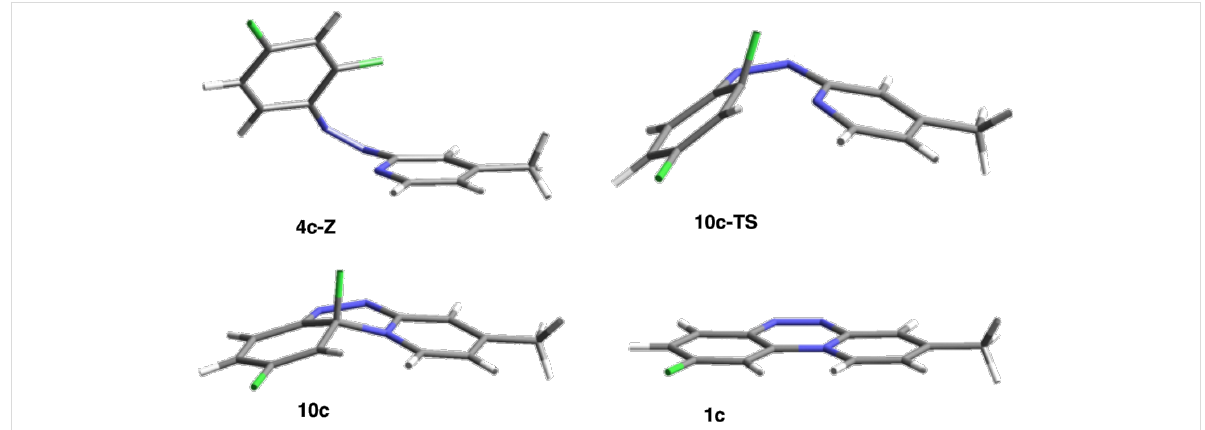
Figure 5: B3LYP/6-311G(2d,p)-optimized geometries for structures involved in cyclization of 4c to 1c .